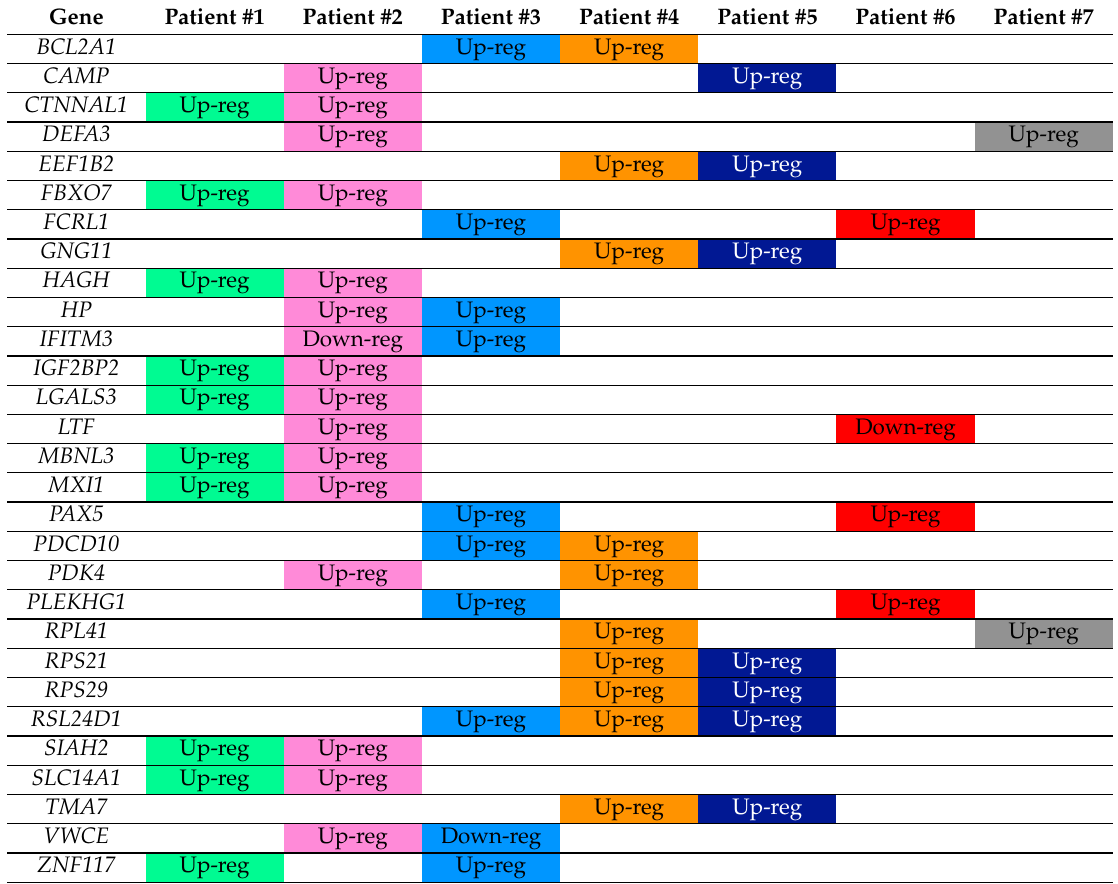
Table 2. Common di ff erentially expressed genes (DEGs) altered only after